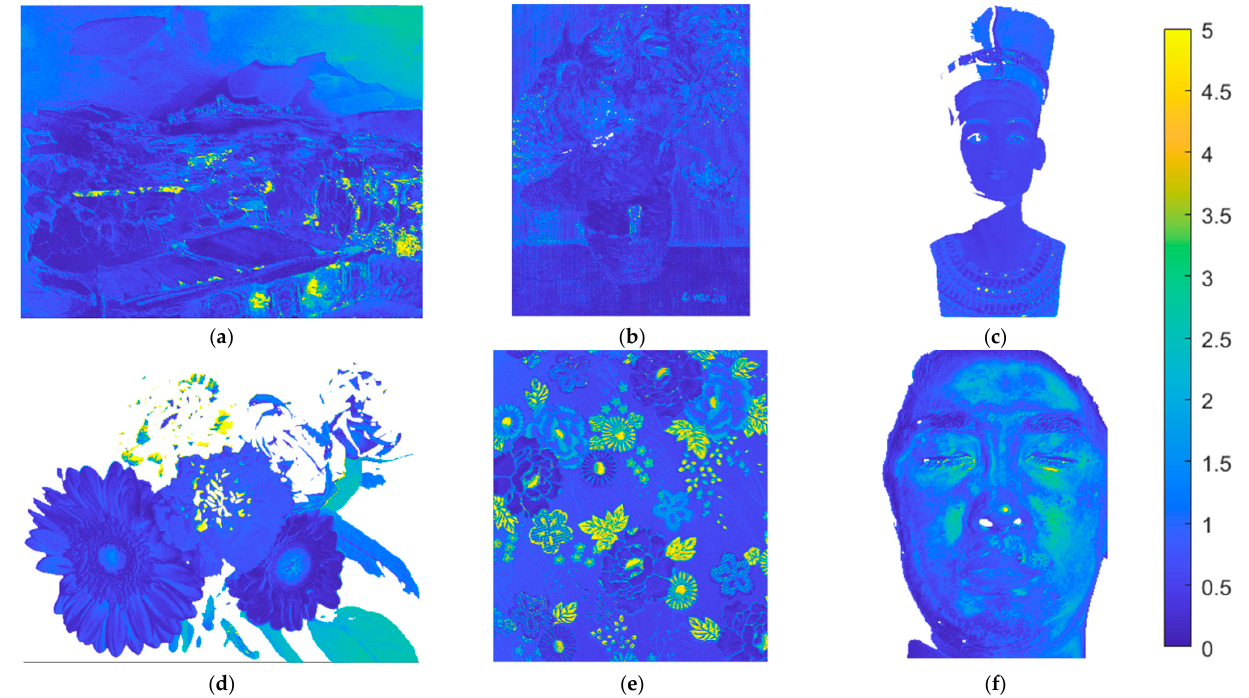
Figure 19. ( a – f ) showing the Δ E 00 maps for the test images in Figure 15a–f, respectively, using the II-wPCA method and RGBF camera. Pixel Δ E 00 values greater than 5.0 are set to 5.0. Several examples of recovering spectral reflectance from the test images are shown below. Figure 20a is the original image (“flowers”) of Figure 15d without removing nearly black pixels. The white circle in the upper left corner is on the black background. Figure 21a shows the spectral reflectance of the pixel in the center of the white circle. From the spectral reflectance, the black background appears to be a dark purple. However, it will be shown that this spectral reflectance is an error, possibly due to the low SNR as previ- ously described. The centers of other seven white circles in Figure 20a are taken as exam- ple pixels. Figure 20b–f show enlarged images of deep purple, red, orange, purple, and yellow flowers, respectively. Enlarged images of the leaf examples at the lower right of Figure 20a are shown in Figure 22a,d. ( a )